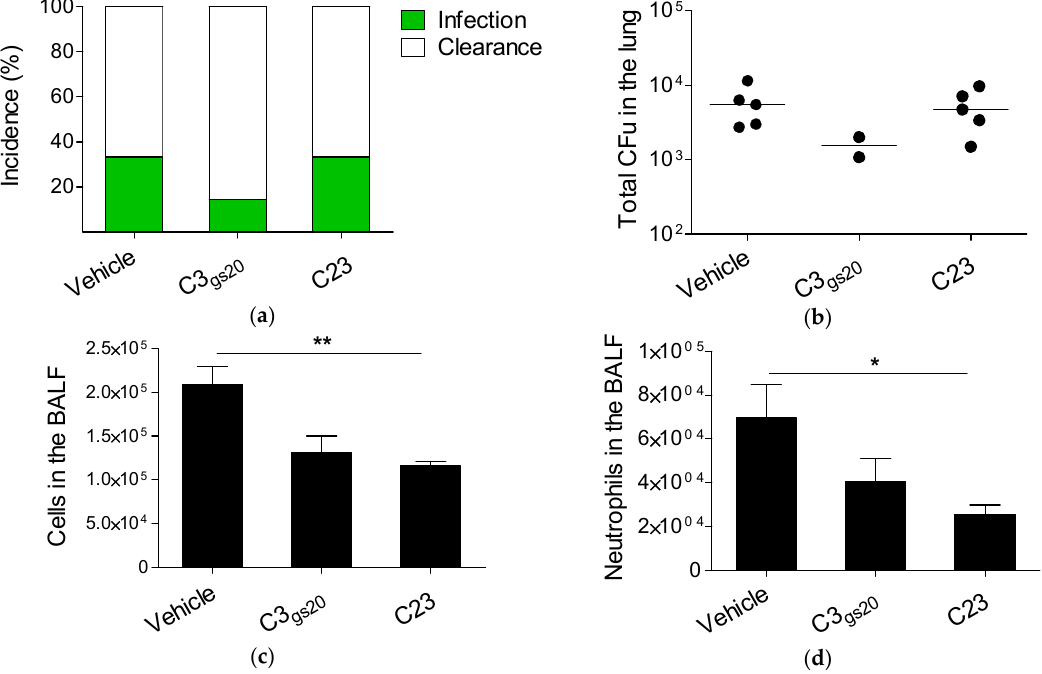
Figure 4. Modulation of the host response by synthesized HS competitors in a mouse model of chronic P. aeruginosa lung infection (14 days). C57Bl/6NcrlBR mice were intratracheally injected with 1–2 × 10 6 CFUs of the P. aeruginosa isolate AA43 embedded in agar-beads. Mice were treated subcutaneously with HS competitors (30 mg/kg) or vehicle every day starting from the day of infection for 14 days. At the sacrifice, BALF and lung were recovered. ( a ) Bacterial clearance (white) and incidence of colonization (green) were determined; ( b ) CFUs were evaluated in total lung of mice still infected at the sacrifice. Total cell ( c ) and neutrophil ( d ) recruitment was analyzed in BALF. The data are pooled from two independent experiments ( n = 14–15). CFUs in individual mice are represented as dots and horizontal lines represent median values. Cells are represented as mean ± SEM. Statistical significance is indicated: * p < 0.05, ** p < 0.01.